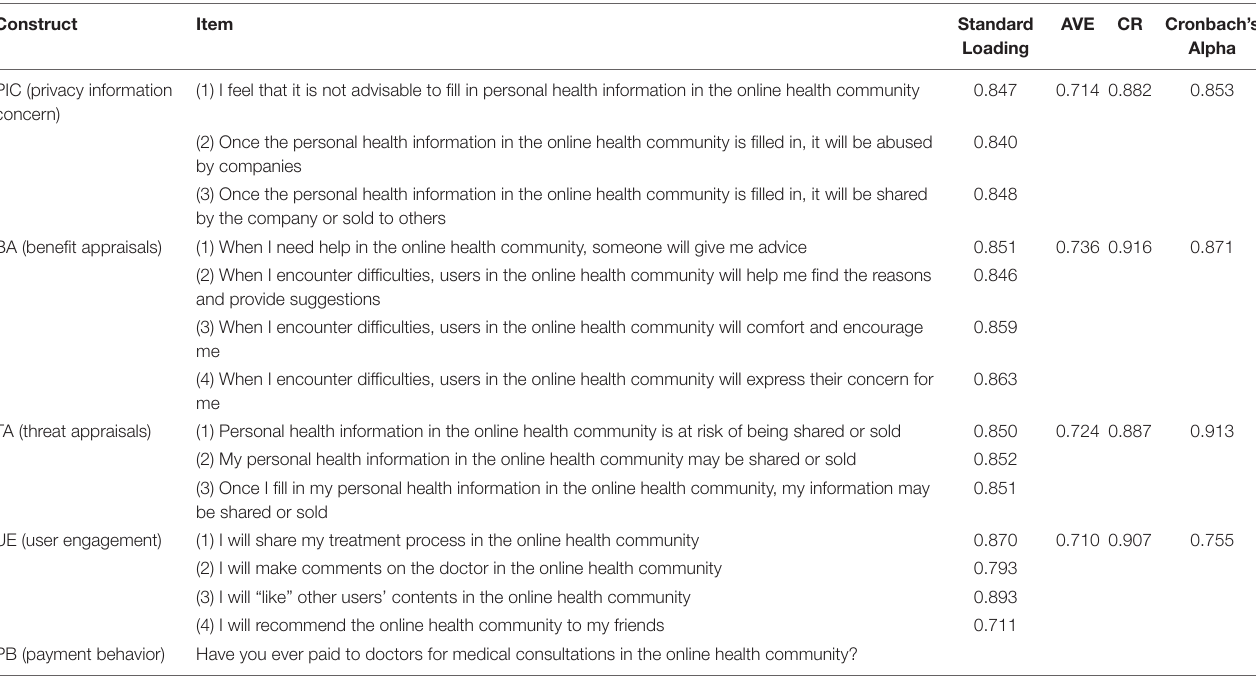
TABLE 2 | Research constructs, measurements, item loadings, and validities. Construct